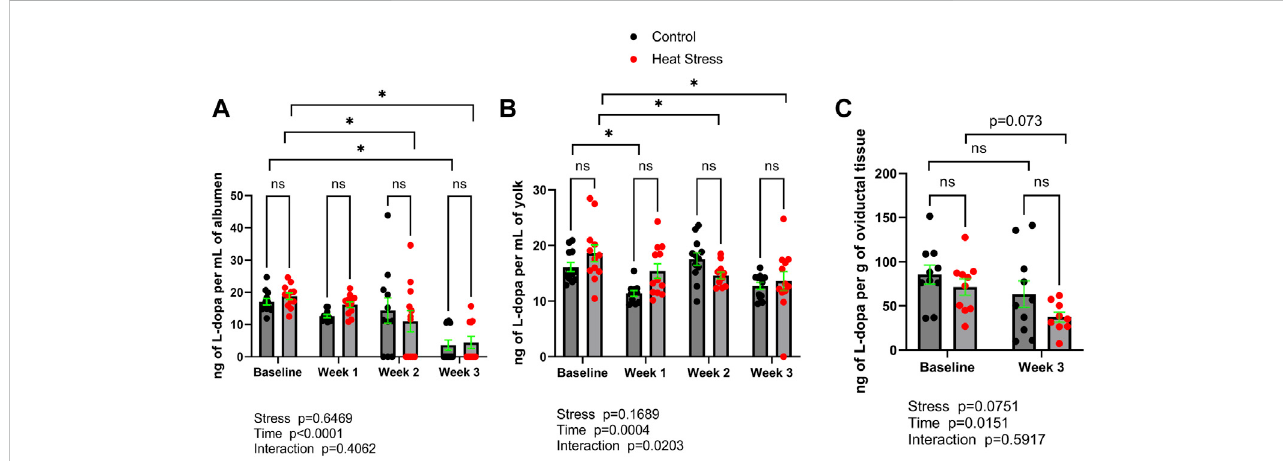
FIGURE 2 L-3,4-dihydroxyphenylalanine(L-dopa)concentrationsinalbumen (A) ,yolk (B) ,oroviductaltissue (C) incontrolorheatstressgroupsatbaselineorafter 1, 2, or 3 weeks of heat stress. Signi fi cant differences ( p < 0.05) were indicated with *. Values are ng per mL of albumen or yolk, or ng per g of oviductal tissue. All values are expressed as mean ± SEM ( n = 12 eggs/timepoint/group or for oviductal tissue n = 9 – 10